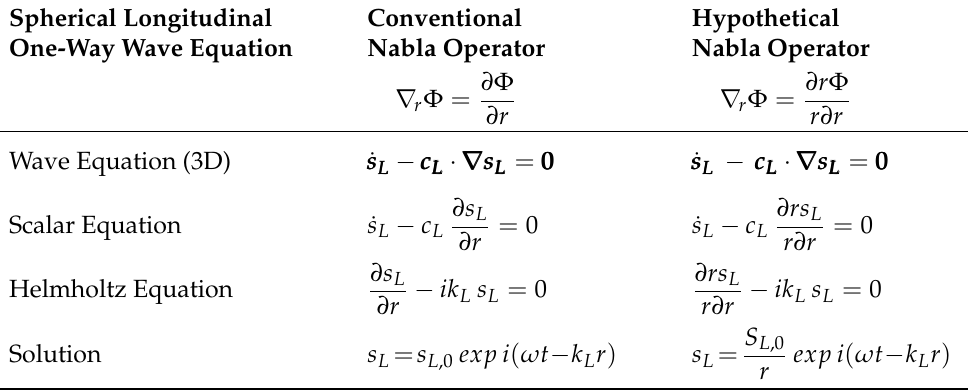
Table 5. Spherical longitudinal wave propagation in an unlimited, elastic continuum without boundary effects according to the spherical one-way wave equation. For reasons of simplicity and definiteness linearity, homogeneity, isotropy and losslessness are assumed. The table compares the wave equations and their solutions using conventional and hypothetical Nabla operators. For the conventional Nabla operator results a plane wave with constant amplitude. For the hypothetical Nabla operator follows a solution with the usual 1/ r amplitude decrease of spherical